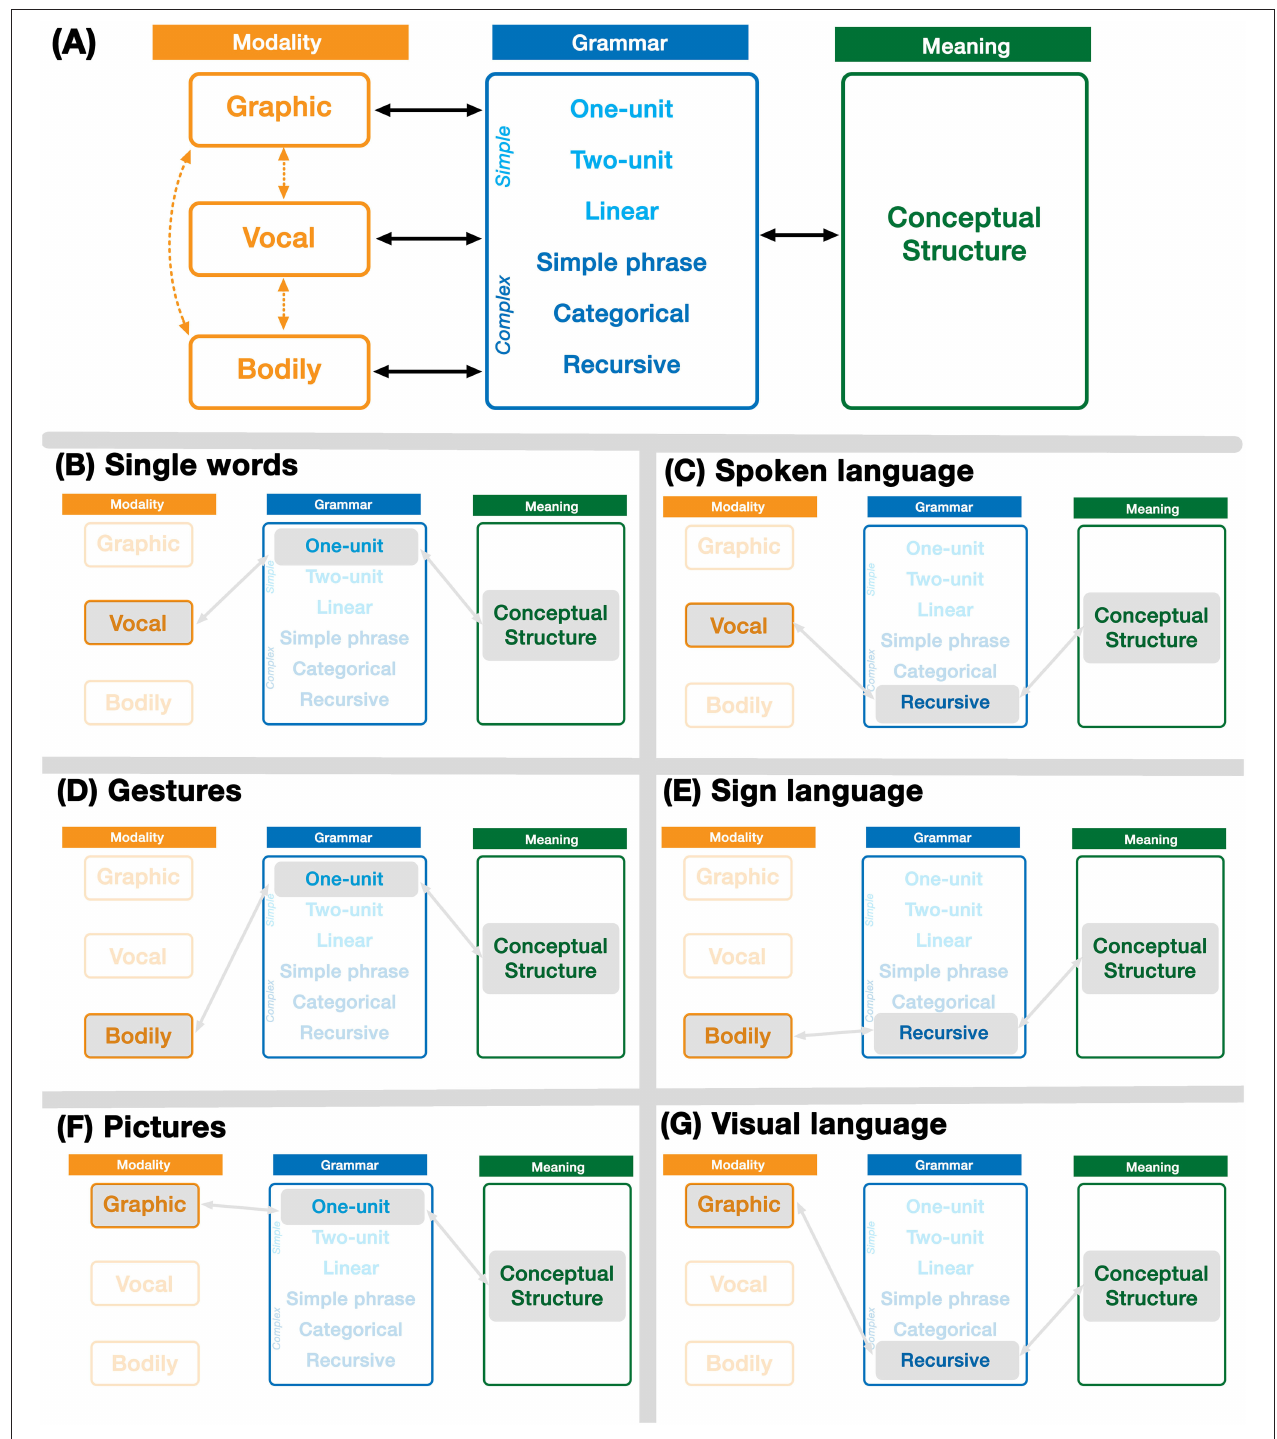
FIGURE 2 | The Parallel Architecture including multiple modalities. Expressive forms arise through emergent states within the full architecture (A) . These include single unit expressions (B,D,F) and potentially full languages using recursive grammars (C,E,G) .